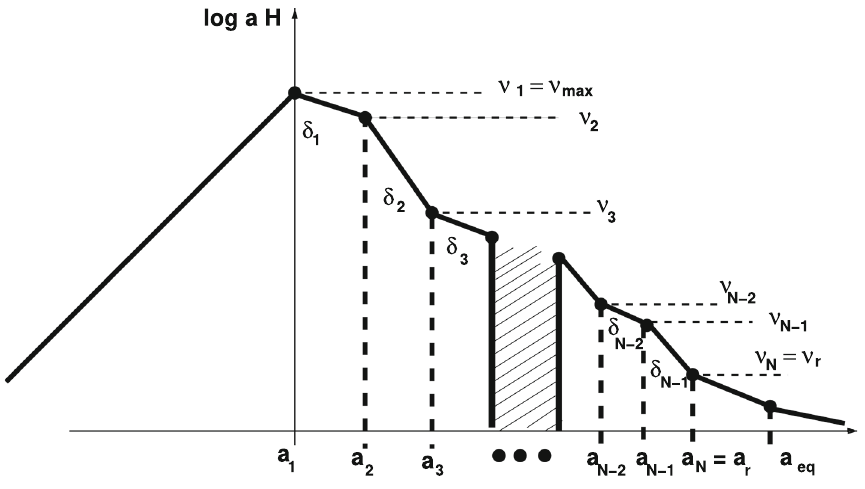
Fig. 1 On the vertical axis the common logarithm of a H is illustrated as a function of the common logarithm of the scale factor. We con- sider here the general situation where there are N different stages of expansion not necessarily coinciding with radiation. The N -th stage conventionally coincides with the standard radiation-dominated evolu- tion (i.e. a r = a N ) while the first stage starts at the end of inflation